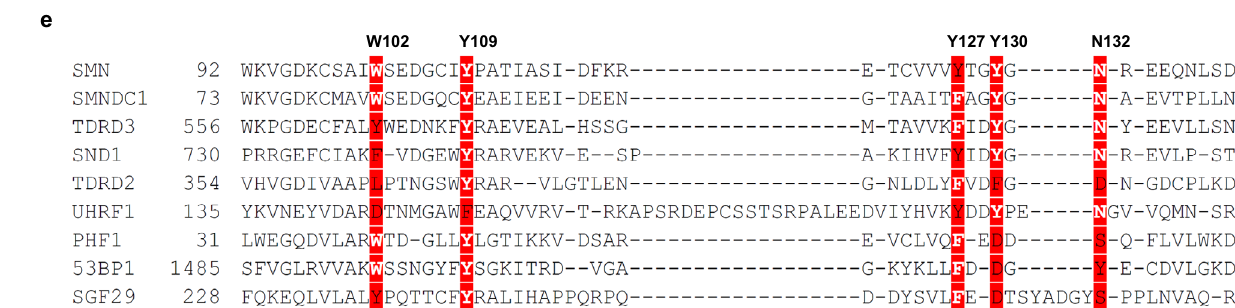
mutants determined by ITC. Shown are representative of two independent experiments. e Sequence alignment of selected Tudor domains. The compound 1 interacting residues were highlighted in red background. Structure fi gures were generated in PyMOL. Surface representations were calculated with the built-in proteincontactpotentialfunctionof PyMOL.Source dataareprovidedasaSource Data fi